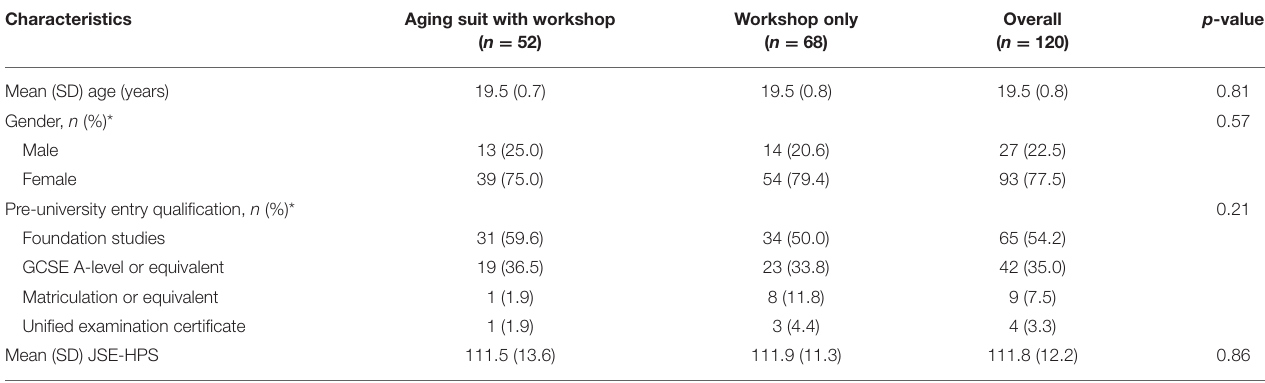
TABLE 2 | Demographic characteristics of participants in the